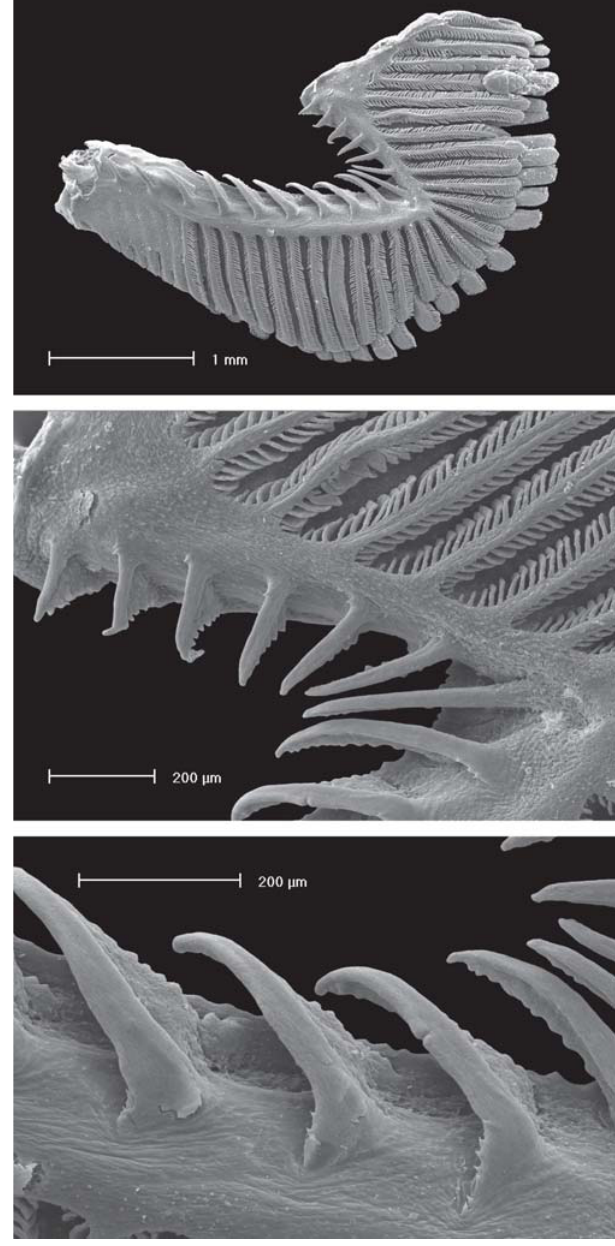
Fig. 20. First gill arch of Odontostilbe splendida , MCP 38862, male 29.7 mm SL: left side, lateral view, showing gill gland (top), in detail gill rakers on upper branchial branch (middle), and gill rakers on lower branchial branch (bottom). Scanning electron micrographs